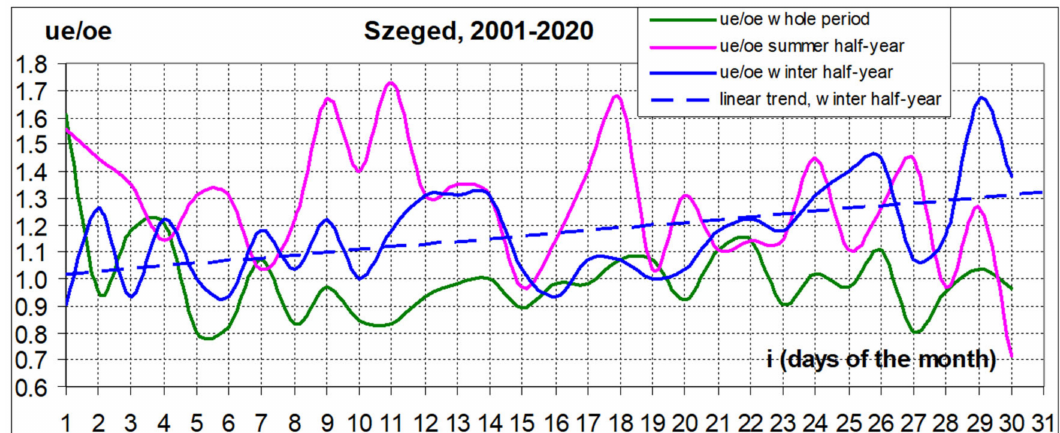
Figure 7. Monthly runs of the ratio of underestimation and overestimation (ue/oe). Figure 8 shows the averages of the absolute deviations | E i | at the estimated time points (as a percentage 100| E i |). We see a marked monthly runs in all three periods, which was very close to the logarithmic trend. According to the correlation index (that measured this connection), the degree of approximation was the best in the summer semester, followed by the whole period and then the winter semester.